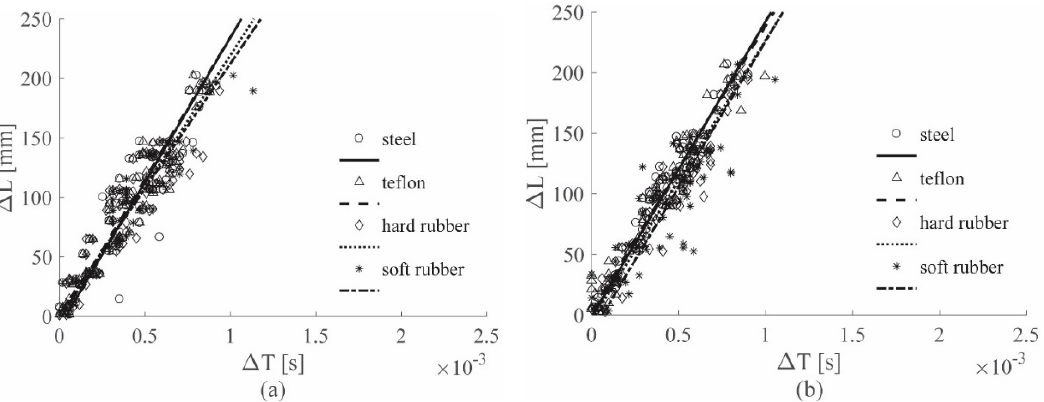
Figure 15. ( Δ L – Δ T ) automatic approach results for sandwich panel, all tips, ACC sensors Figure 15. ( ∆ L – ∆ T ) automatic approach results for sandwich panel, all tips, ACC sensors ( a ) and PZT ( a ) and PZT sensors ( b ), both filtered with the 0–619 Hz filter. sensors ( b ), both filtered with the 0–619 Hz Thus, conclusions identical to those gleaned from the visual approach of Sections 3.1 and 3.2 were drawn.